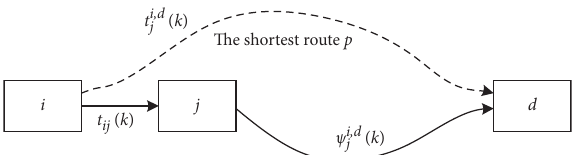
Figure 3: The shortest route was chosen by a pedestrian